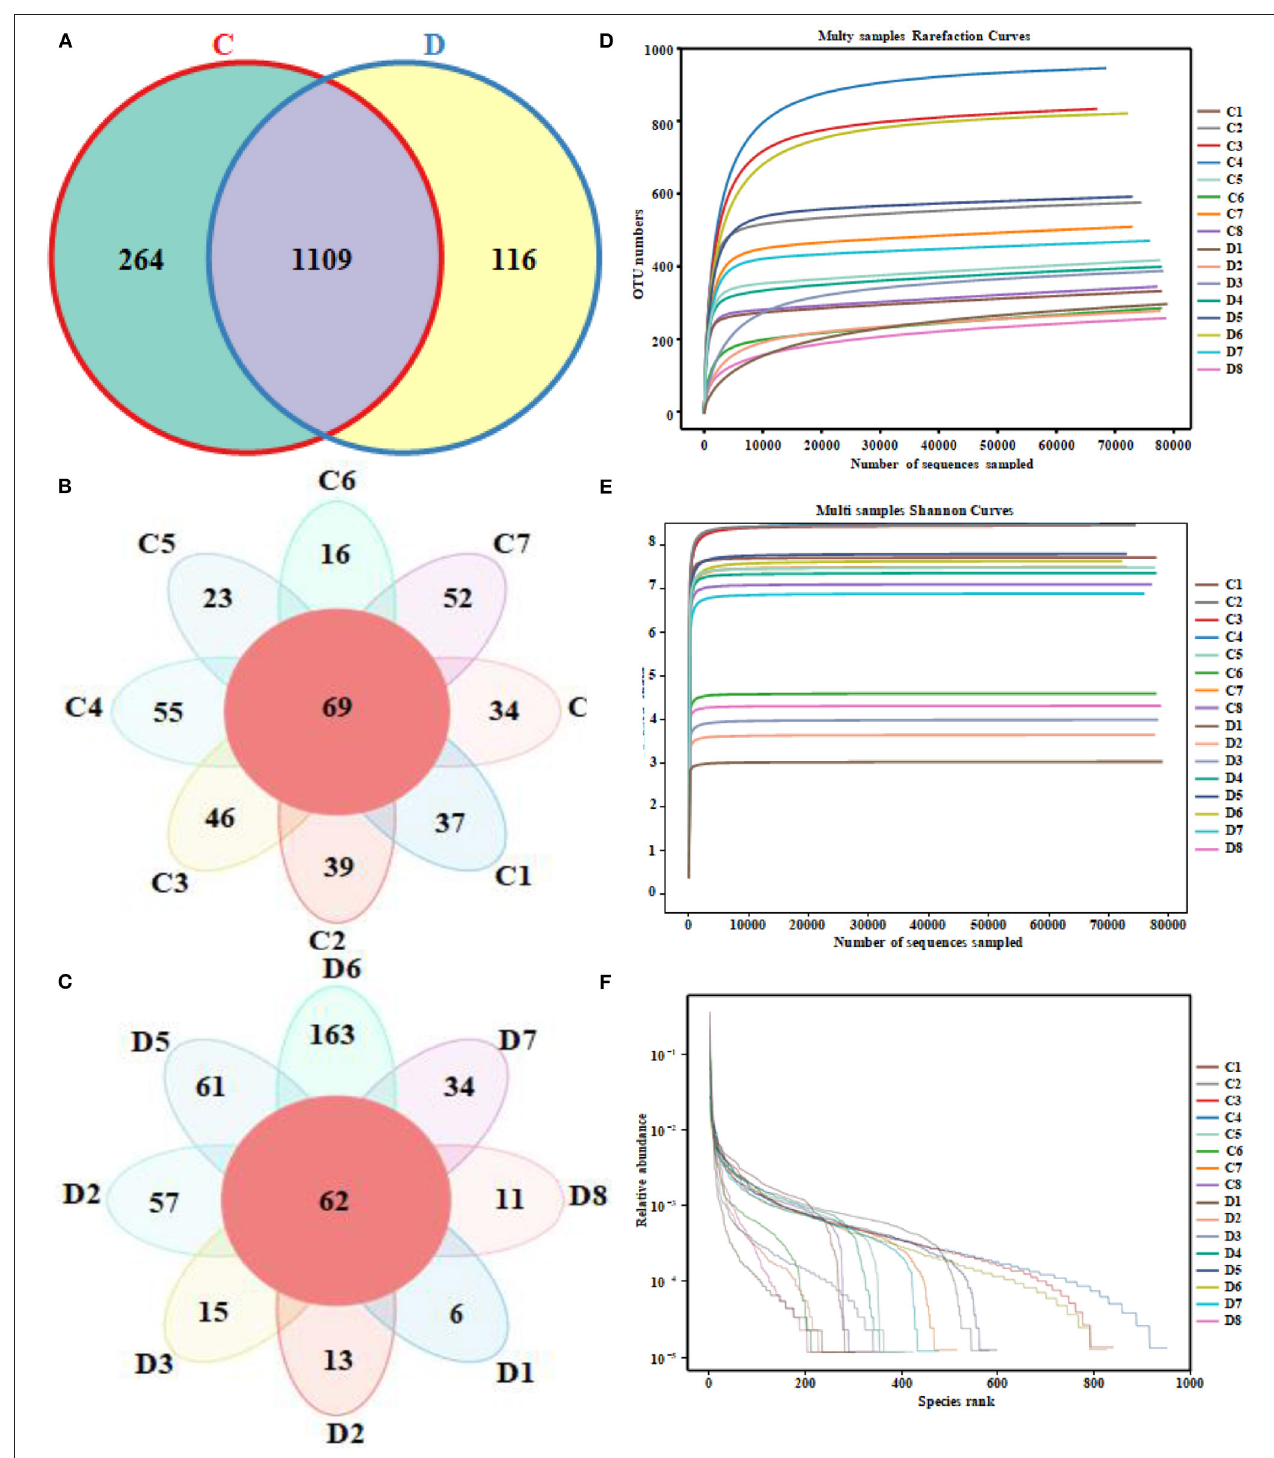
FIGURE 1 | Venn diagrams and sequencing quality evaluation. (A) Venn diagram of operational taxonomic units (OTUs) distribution between group C and group D. (B,C) Flower diagrams of the OTU shared among the samples within the group C and group D, respectively. (D) Rarefaction curve of 16 fecal samples in both groups. (E) Shannon index curve of 16 fecal samples in both groups. (F) Rank abundance curve of 16 fecal samples in both groups.